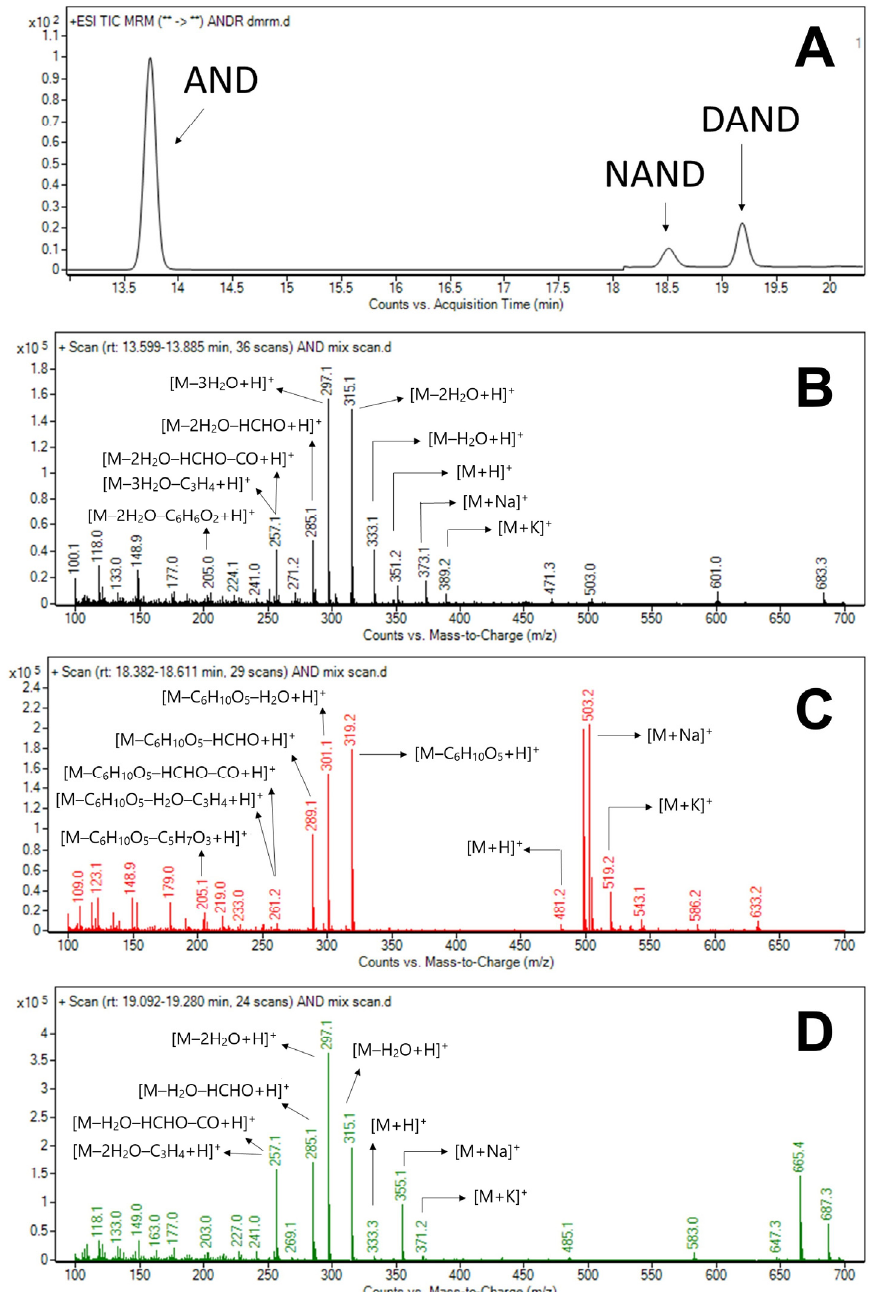
Figure 8. The total ion chromatogram of the standard mixture (10 µg/mL) ( A ) collected in dMRM mode (quantitation transitions ( m/z ): 351 → 297, 481 → 319 and 333 → 297) and full-scan product ion spectra of andrographolide (AND) ( B ), neoandographolide (NAND) ( C ), and 14-deoxy-11,12- didehydroandrographolide (DAND) ( D ).